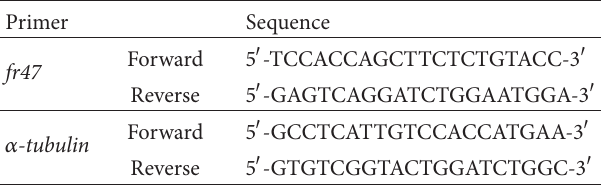
Table 1: List of primers used in this study.